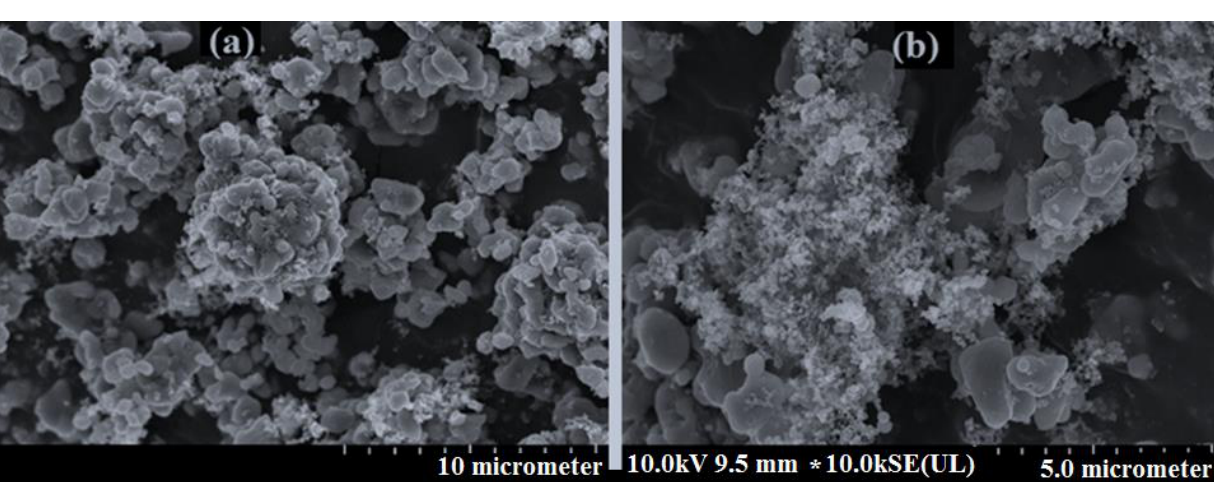
Figure 2. The SEM of four cathode materials for two samples including ( a ) = sample 14= Li 1.167 Fe 0.612 Ti 0.111 Co 0.111 Mn 0.166 PO 4 , ( b ) = sample 18 = Li 1.501 Fe 0.389 Ti 0.055 Co 0.055 Mn 0.501 PO 4 .